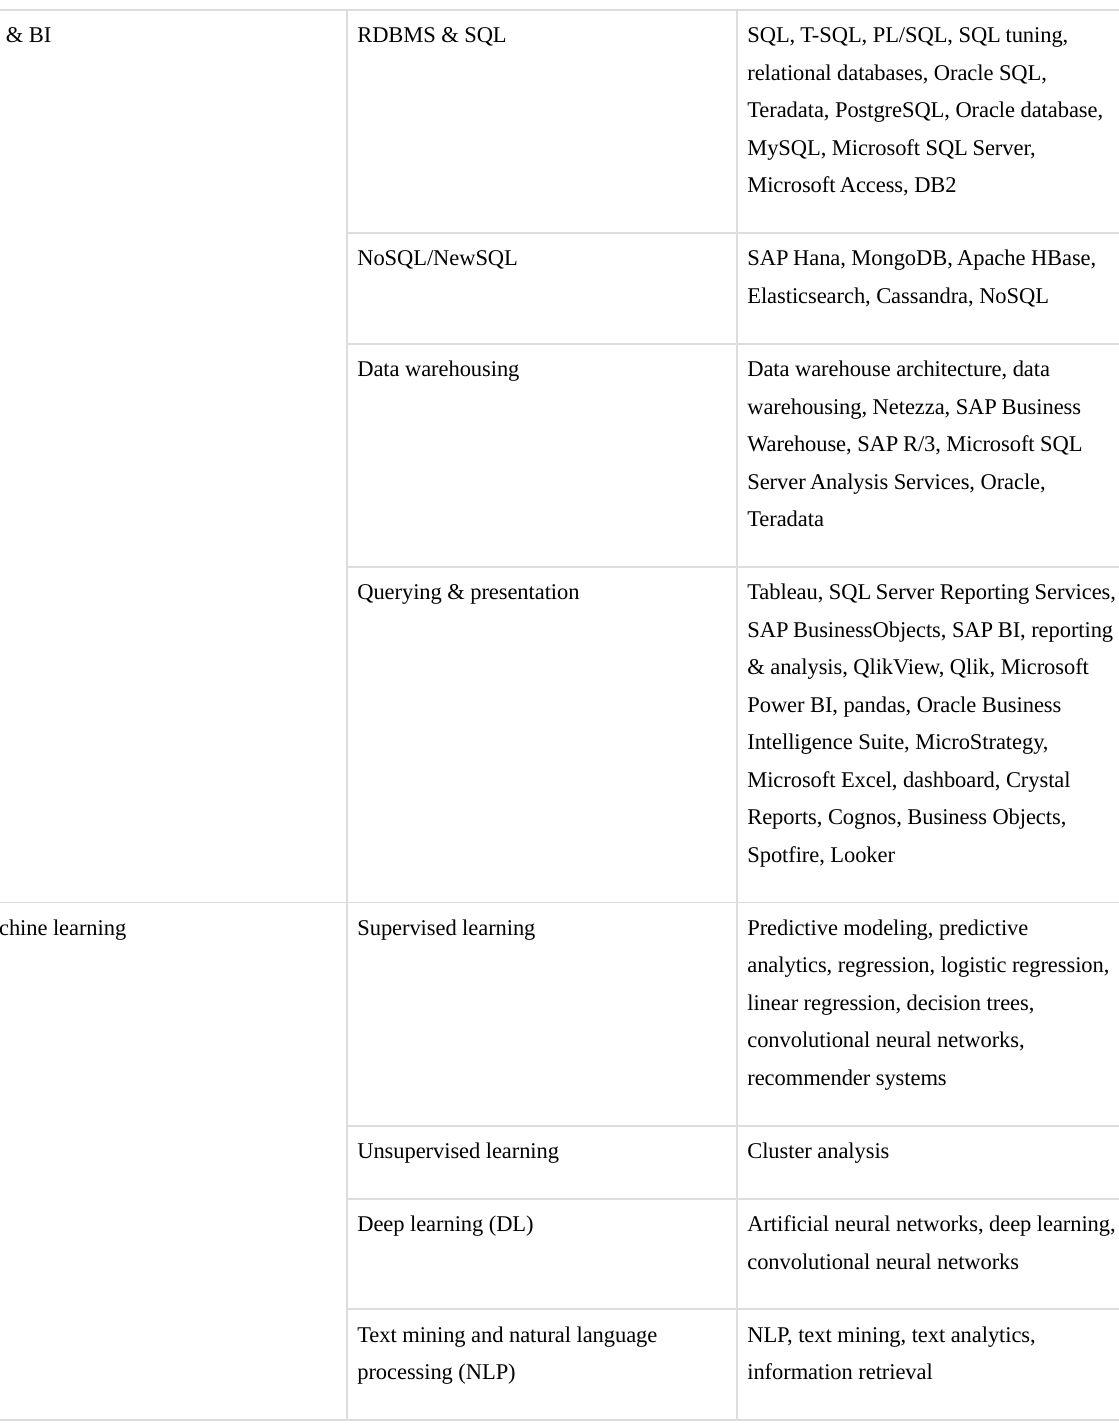
Tableau, SQL Server Reporting